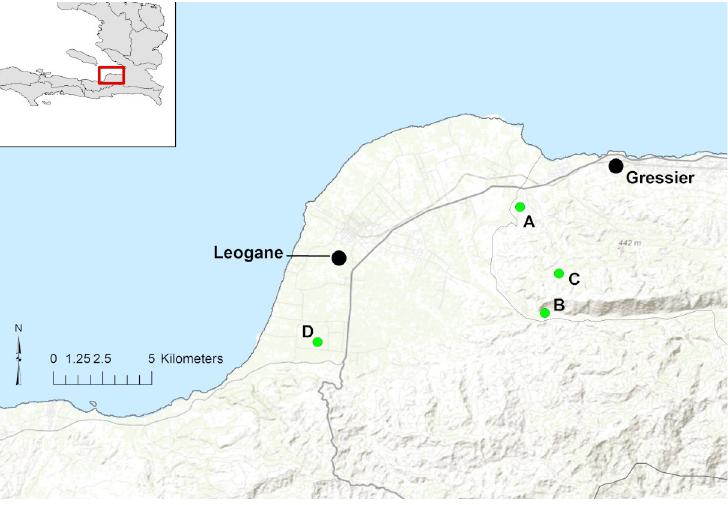
Fig 1. Map of schools enrolled in the study (green dots). Major towns in region are Leogane and Gressier (black dots) plotted over topography. National Route 2, the main highway through the area is identified with a bolded line and smaller roads appear lighter (gray). Base map data from ESRI Online, GIS Use Community and